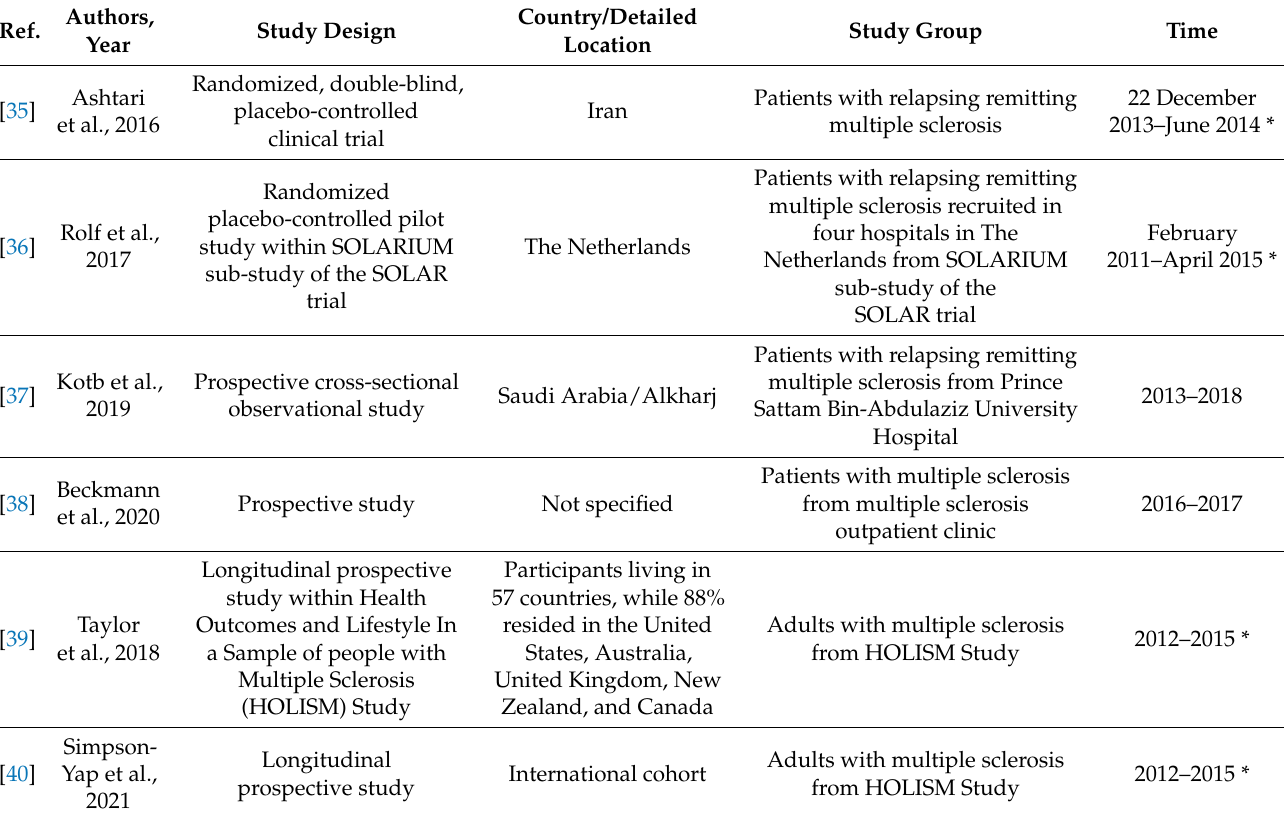
Table 2. The design and basic details of the studies of multiple sclerosis (MS) patients included to the systematic review. Authors, Ref.